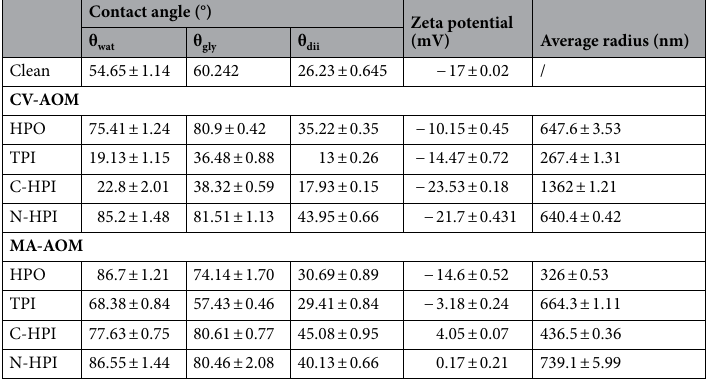
Table 4. Properties of the membrane and IOM fractions. Contact angle values are given as mean value ± standard deviation (n = 10), zeta potential and average radius values are given as mean value ± standard deviation (n =